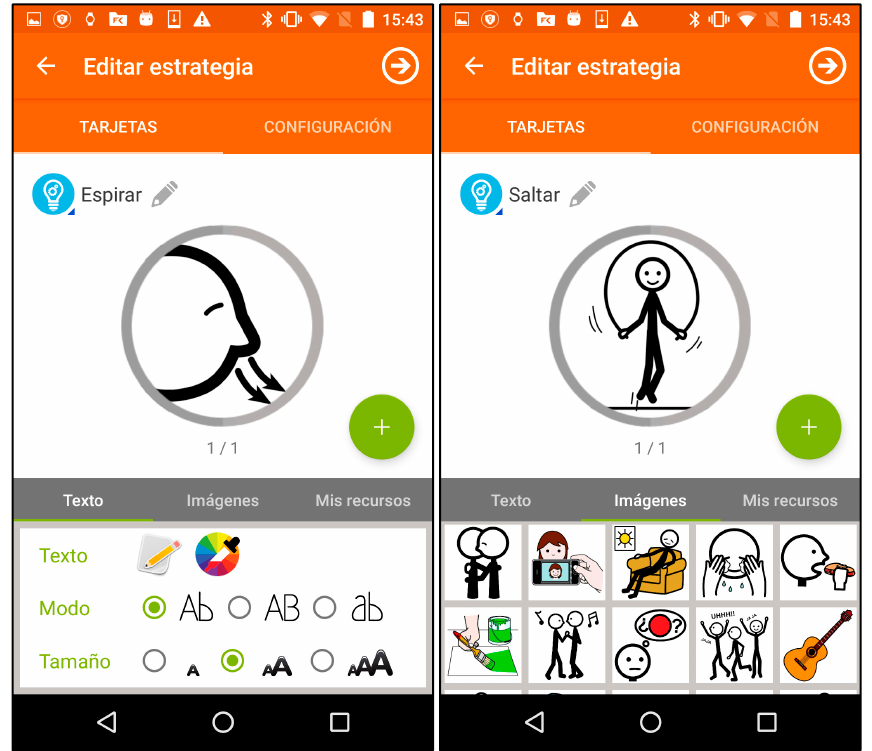
Figure 7. Authoring tool screenshots.